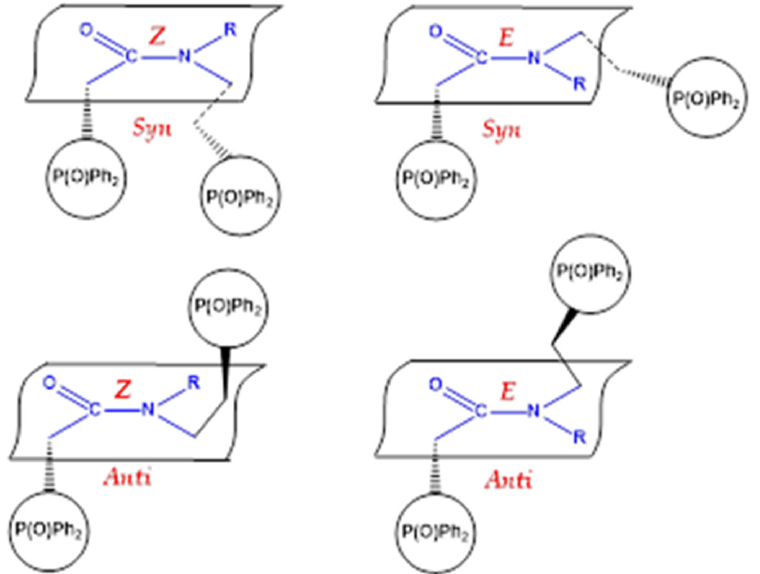
Figure 6. Structures of preferred conformers of 1 – 3 .